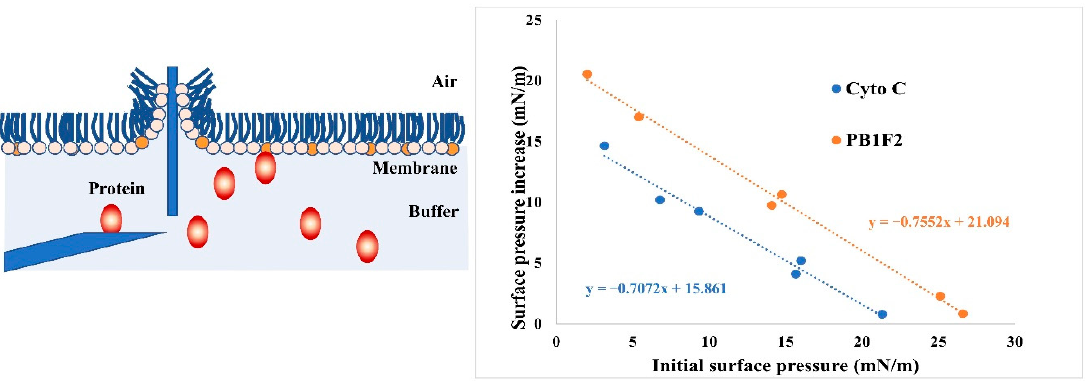
Figure 4. Schematic diagram and results of LB Microtrough analysis. The PB1F2 or cytochrome c was injected underneath the monolayer (PC+cardiolipin). MIPs of PB1F2 and cytochrome c (Cyto C) are calculated from lines fitted in this graph.